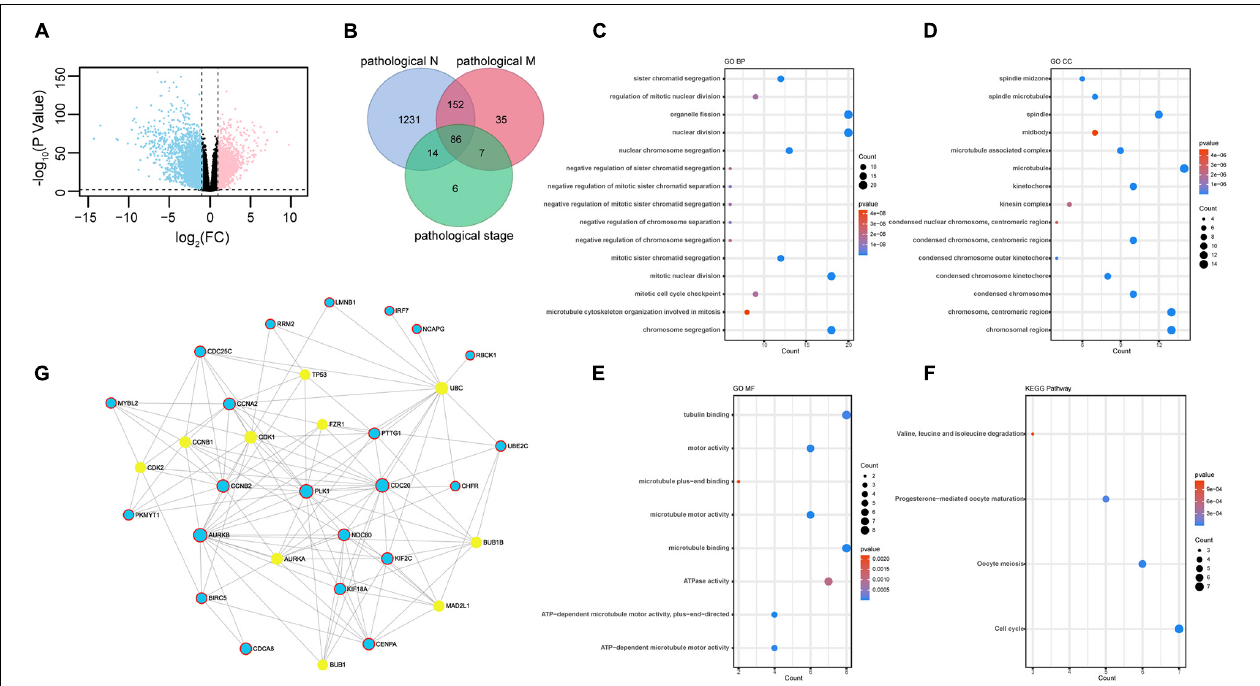
FIGURE 1 | Identification of differently expressed genes: (A) 4,933 DEGs identified in ccRCC TCGA dataset plotted in the volcano plot, in which the logarithmic ratio of FC of the tumor/normal are plotted against negative logarithmic P -values; 2,571 genes were significantly downregulated (blue); 2,362 genes were upregulated (red) (| fold change| > 2, p < 0.01). (B) Venn diagram of metastasis-related genes in ccRCC in TCGA dataset. A total of 86 genes showed significant association with pathological M ( p < 0.05), pathological N ( p < 1E-5), and pathological stage ( p < 1E-10). (C–F) GO terms representing BP, CC, and MF and KEGG pathway analysis. (G) PPI network of 86 DEGs. The 22 seeds genes are shown in blue. The STRING Interactome database was selected to construct PPI, and the confidence score cutoff was set as 900; degree filter threshold values >